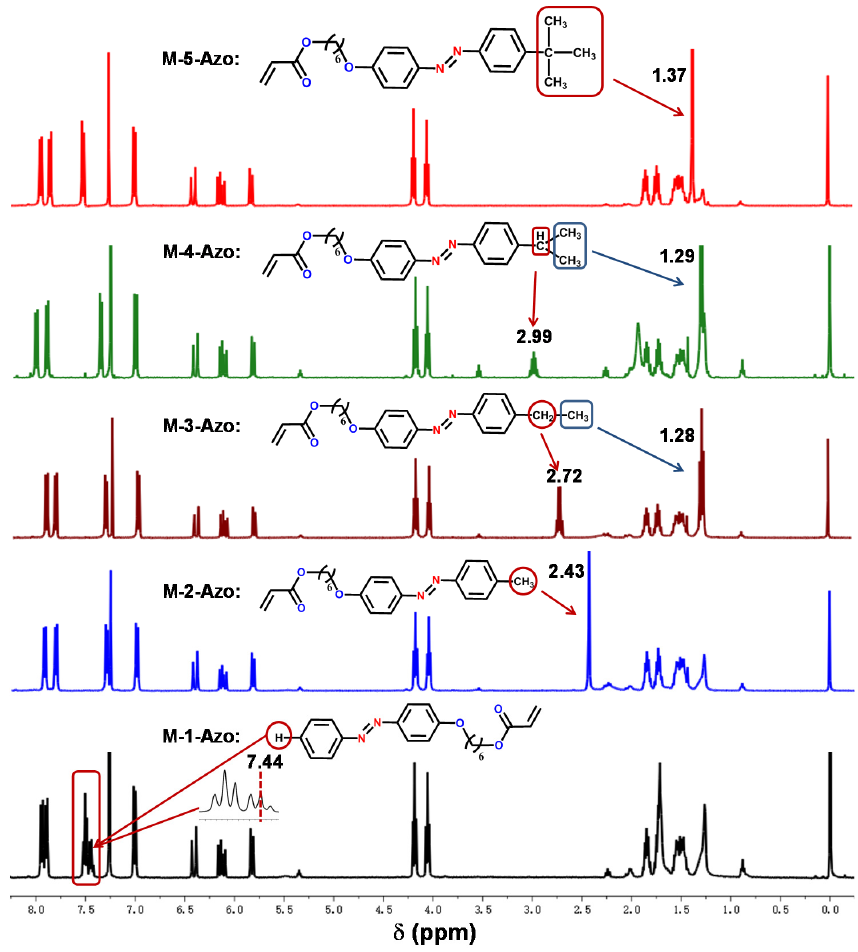
Figure 2. 1 H NMR of monomers M-n-Azo ( n = 1–5).